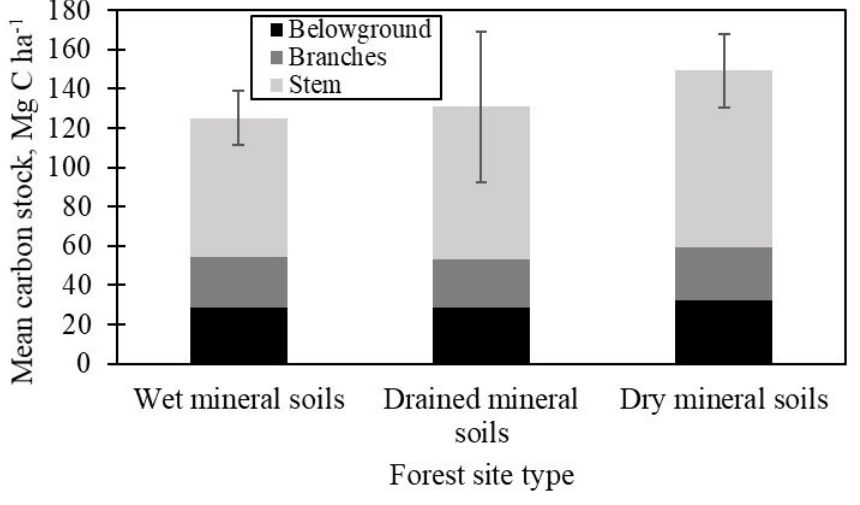
Figure 1. Mean carbon stock of tree biomass components (±95% confidence interval of mean total tree biomass carbon stock) between the forest site types.